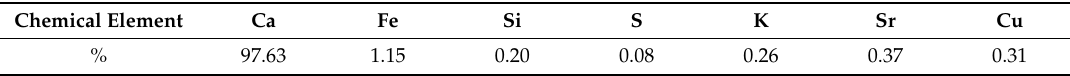
Table 3. Elementary compositional analysis for Indiana limestone.